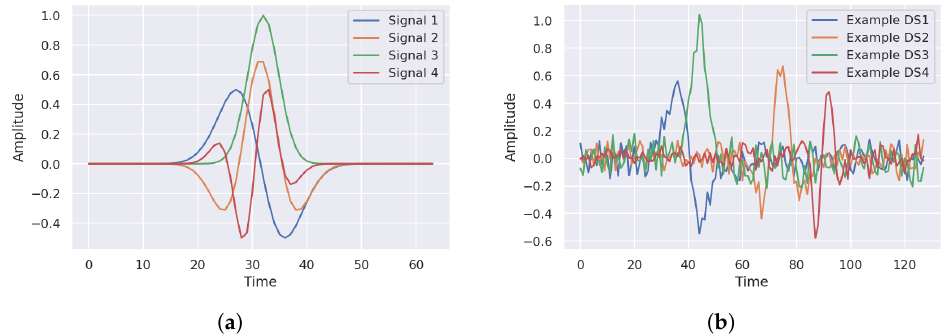
Figure 3. Template signals and random examples of the synthetic dataset. ( a ) Template signals used in generating the synthetic dataset ( N = 4). ( b ) Random signals of the synthetic dataset examples with %50 noise-to-signal